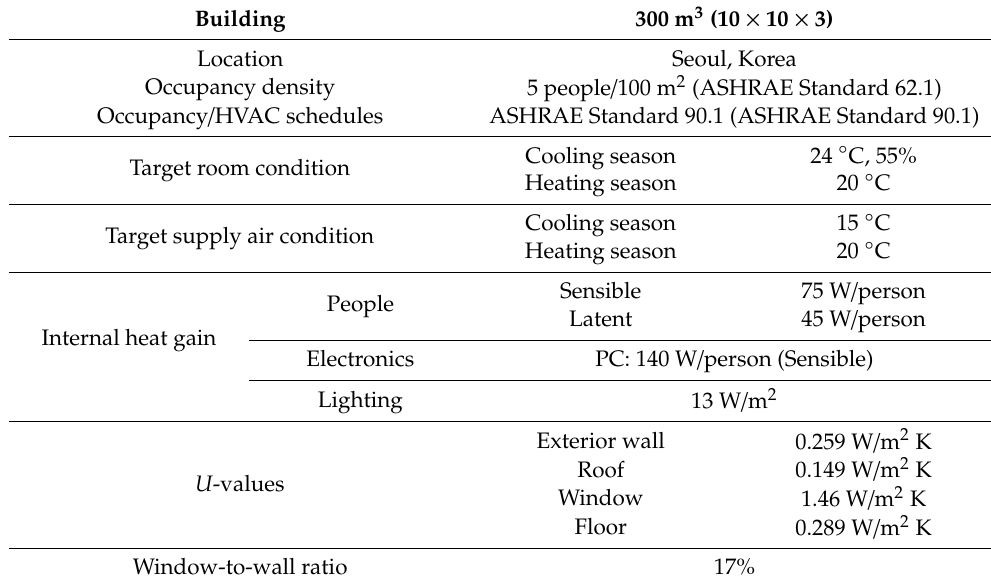
Table 1. Information of the model buildings studied